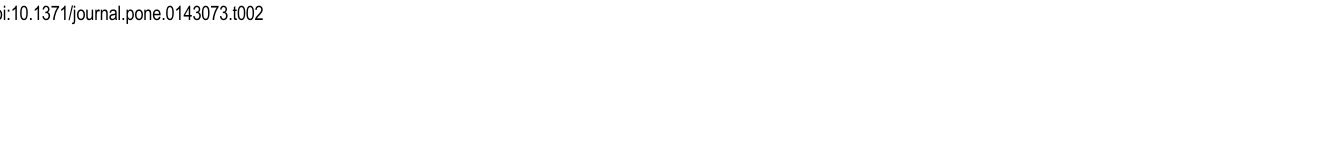
Table 2. Multivariate Cox regression analysis of time to first therapy in 11q- CLL patients with respect to the number of losses detected by FISH: < 40% (n = 51) or (cid:1) 40% (n = 146). *